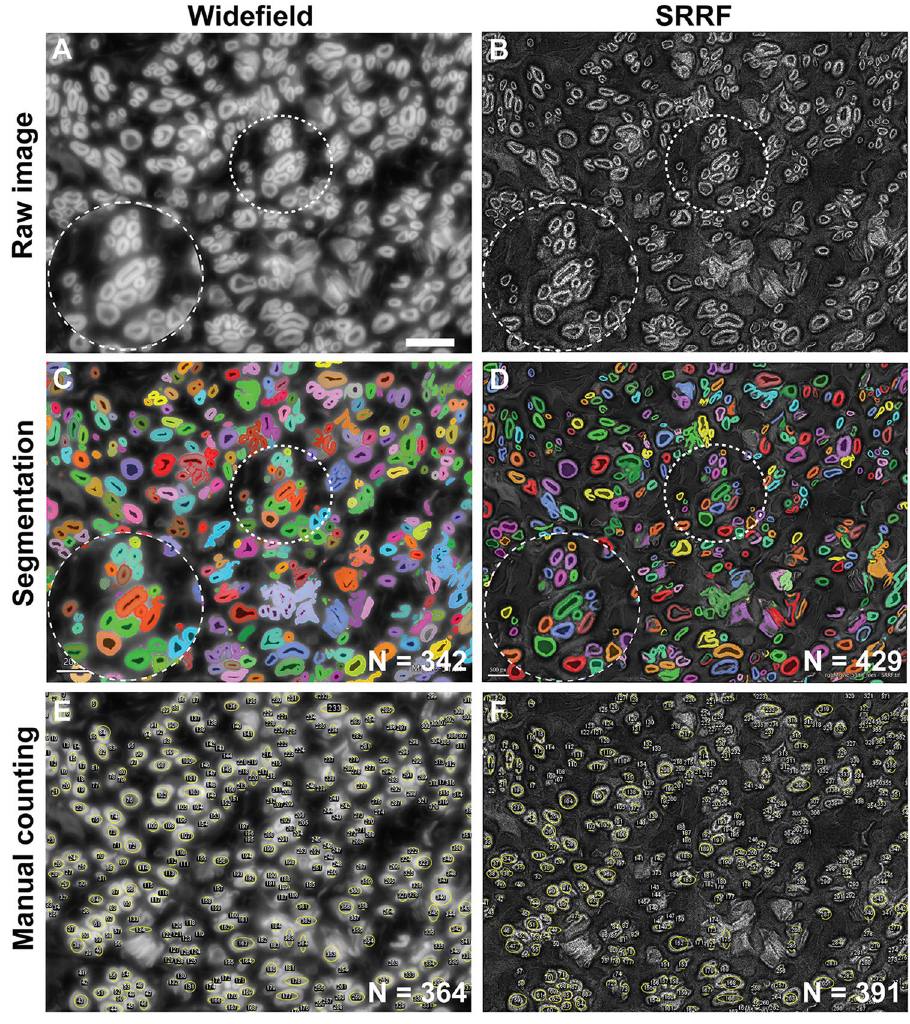
Figure 5. Super-resolution imaging of regenerating human nerve labelled with a myelin-specific dye. Biopsy of a human cross-facial nerve autograft harvested at time of functional muscle transfer, cryosectioned at 2 µm, and stained with FluoroMyelin Green. ( A,B ) Resolution enhancement using SRRF imaging is demonstrated in comparison to widefield fluorescence imaging. ( C,D ) Resulting image segmentation using machine